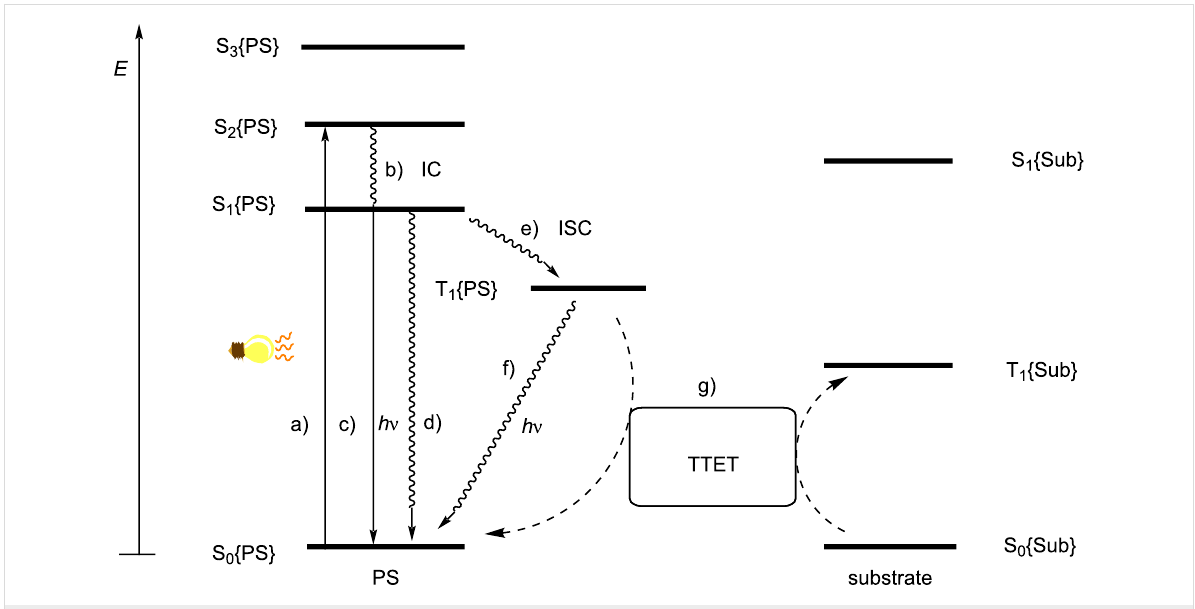
Figure 3: Jablonski diagram showing visible-light-induced energy transfer pathways: a) absorption, b) IC, c) fluorescence, d) radiationless transitions, e) ISC, f) phosphorescence and g) TTET.